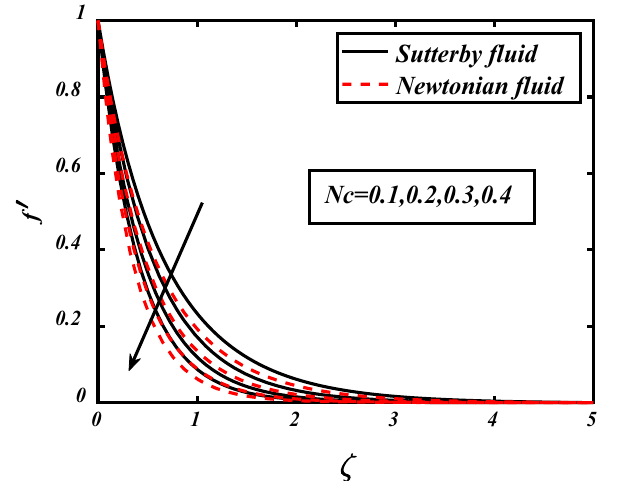
Figure 5. Expounds the impacts of Nc on f ′ .